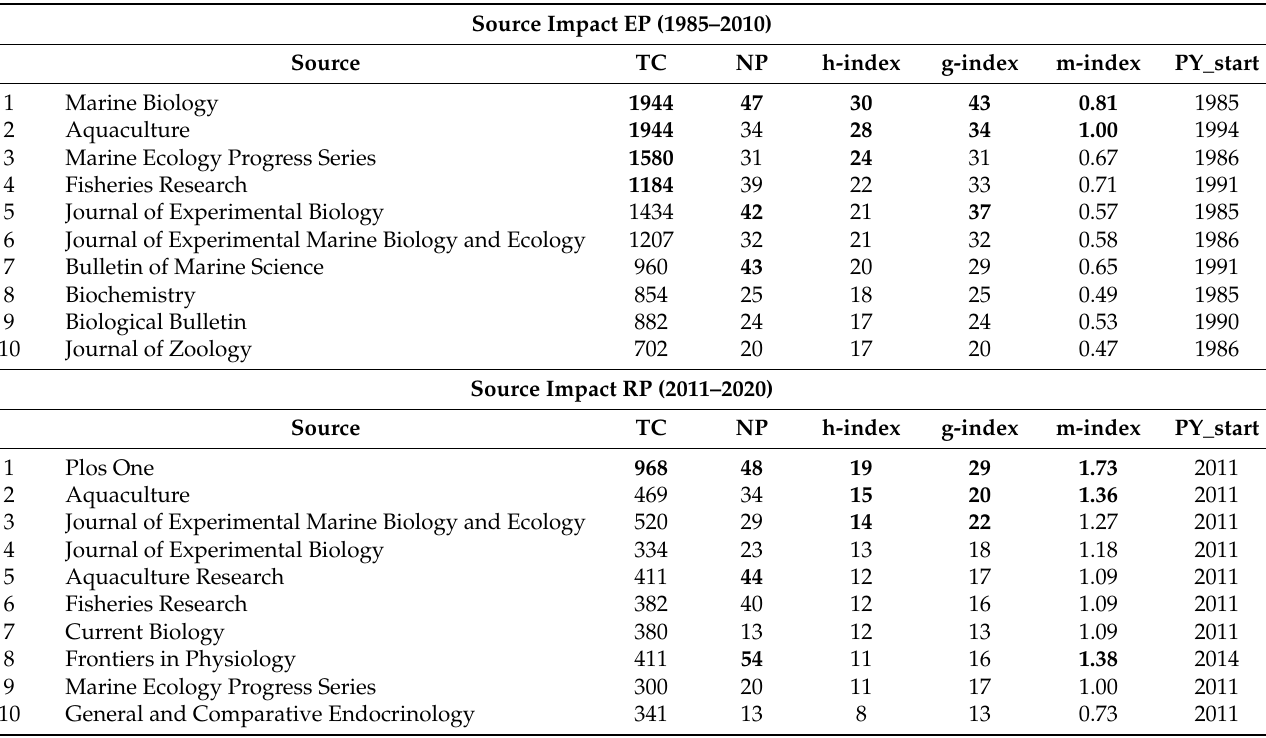
Table 2. Information on the first ten sources ordered according to the h-index, from 1985 to 2010 (“earlier period”: EP) and 2011 to 2020 (“recent period”: RP). NP: number of publications; TC: total citations; h-index: journal’s number of published articles (h), each of which has been cited in other papers at least h time; g-index: the largest number such that the top